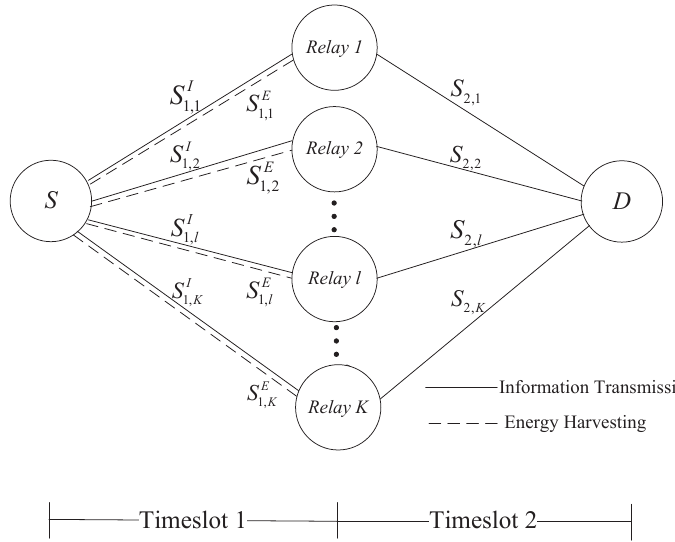
Figure 1. System model. Source S , destination D , and K